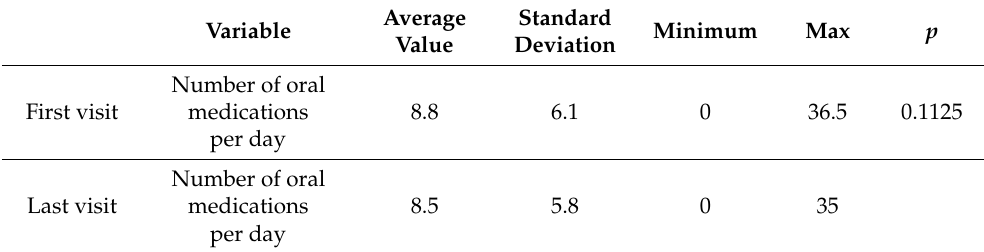
Table 5. Number of drugs taken per day at the first and last home